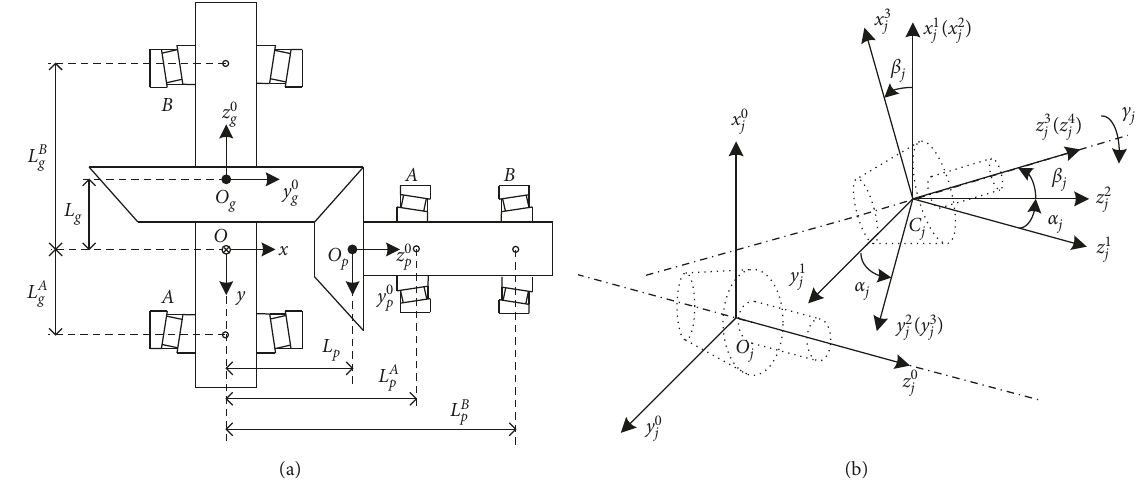
Figure 15: (a) Gear pair model and (b) coordinate systems of each gear-shaft